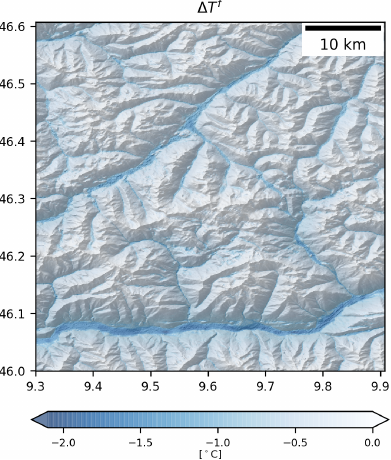
Figure 14. The fine scale of land-surface influence ( (cid:49)T f ) for the test